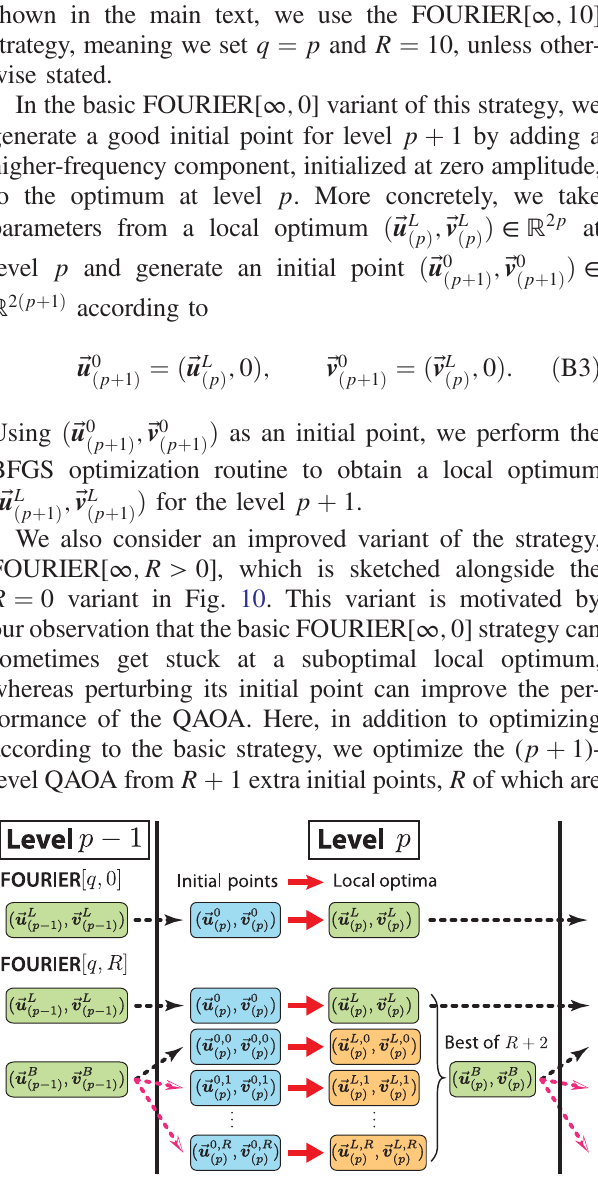
FIG. 10. Schematics of the two variants of the FOURIER[ q , R ] heuristic strategy for optimizing the QAOA, when R ¼ 0 and R > 0 . Optimized parameters (green) at level p − 1 are used to generate good initial points (blue) for optimizing at level p ; the same process is repeated to optimize for level p þ 1 . When generating initial points, black dashed arrows indicate appending a higher-frequency component [Eq. (B3)], and pink dashed arrows correspond to adding random perturbations [Eq. (B4)]. In the R > 0 variant, two local optima (green) are kept in parallel at each level p for generating good initial points: ð ⃗ u L same optimum obtained from the FOURIER[ q; 0 ] strategy, and ; ⃗ v B ð ⃗ u B Þ is the best of R þ 2 local optima, R of which are ð p Þ ð p Þ obtained from perturbed initial points. We find that keeping the ; ⃗ v L ð ⃗ u L Þ optimum improves the stability of the heuristic, as ð p Þ ð p Þ random perturbations can sometimes lead to erratic and non- smooth optimized